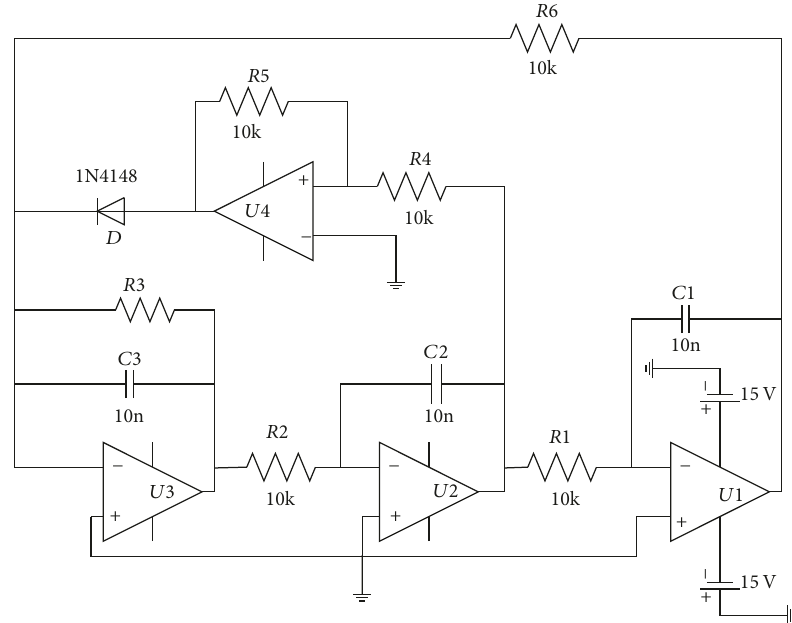
Figure 1: Electronic circuit realization of the simple chaotic jerk system under consideration. The simplicity of the circuit is remarkable: only RC components, a diode, and a quadruple op. amplifier (TL084) are involved. The circuit has been built using the sets of element values as shown in the figure. 𝑅 3 is tuneable element used as bifurcation control parameter. OA 1 , OA 2 , OA 3 , and OA 4 are TL084 type or equivalent operational amplifiers. 𝐷 is a general purpose diode; here 𝐷 = 1 N 4148 ( 𝜂 = 1.9 , 𝑉 𝑇 = 26 mV, and 𝐼 𝑆 = 2.682 nA). 𝐶 1 = 𝐶 2 = 𝐶 3 = 𝐶 = 10 nF; 𝑅 = 𝑅 = 𝑅 = 𝑅 = 𝑅 = 𝑅 = 10 k Ω 1 2 4 5 6